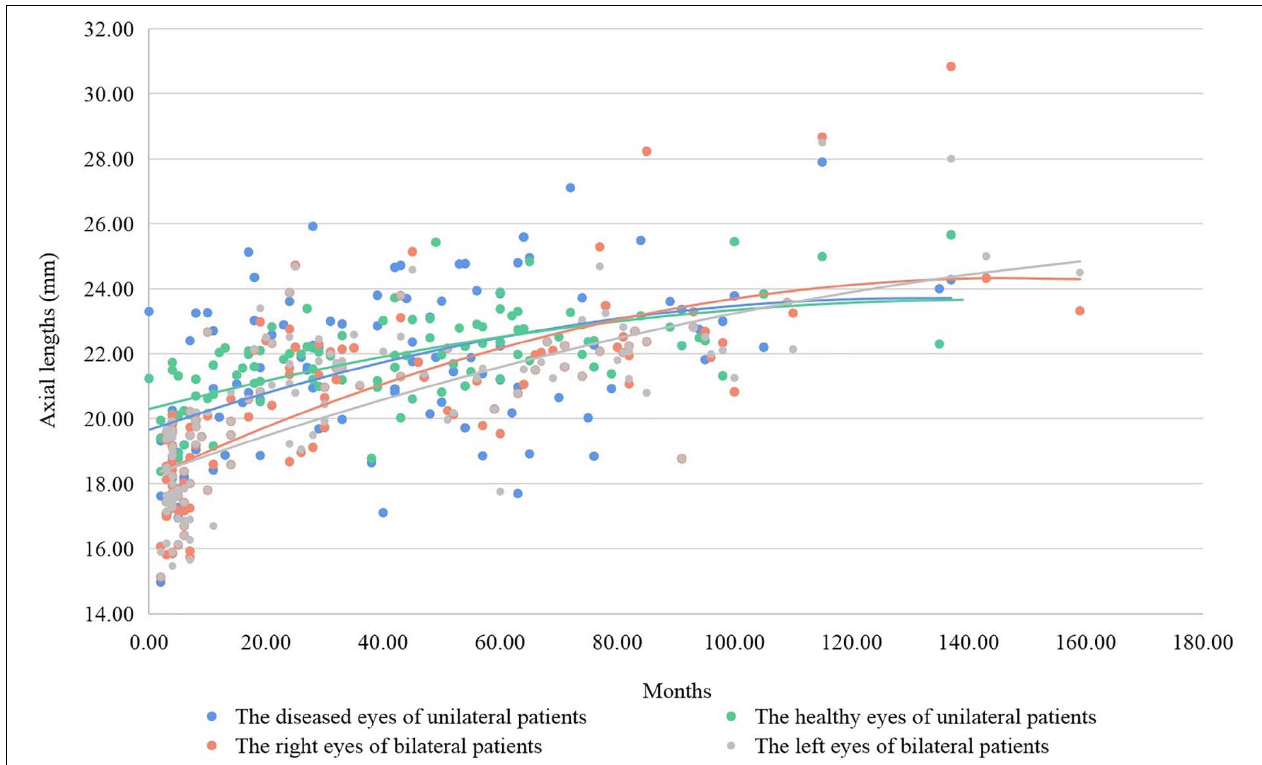
FIGURE 2 | The axial lengths and growing fit lines of patients according to laterality. The axial lengths of unilateral patients were longer than those of bilateral patients before 7 years of age, and the axial lengths of bilateral patients became longer than those of unilateral patients after 7 years of age. The axial lengths of the healthy eyes of unilateral patients were longer than those of the diseased eyes before 6 years of age, and the axial lengths of the diseased eyes of unilateral patients became close to the healthy eyes of unilateral patients after 6 years of